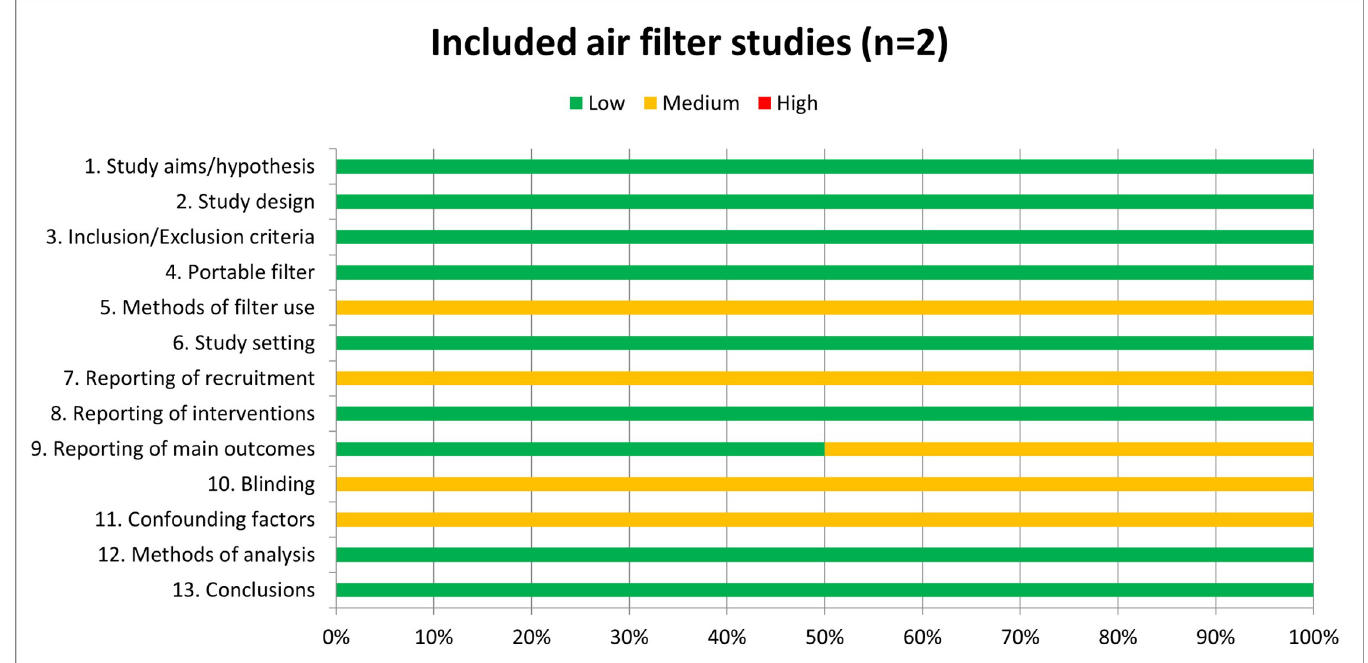
Fig 2. Data quality charts based on CASP checklist.